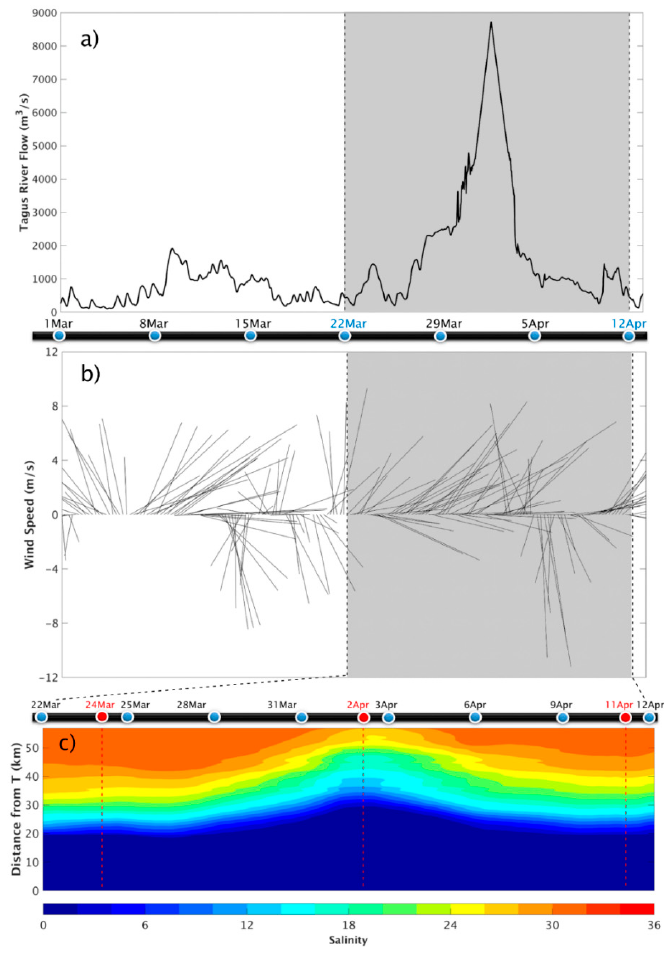
Figure 3. March/April of 2013 Event Characterization. ( a ) Freshwater discharge of Tagus River; ( b ) wind velocity; ( c ) average value of salinity over the longitudinal section beginning at the point T (see Figure 1).